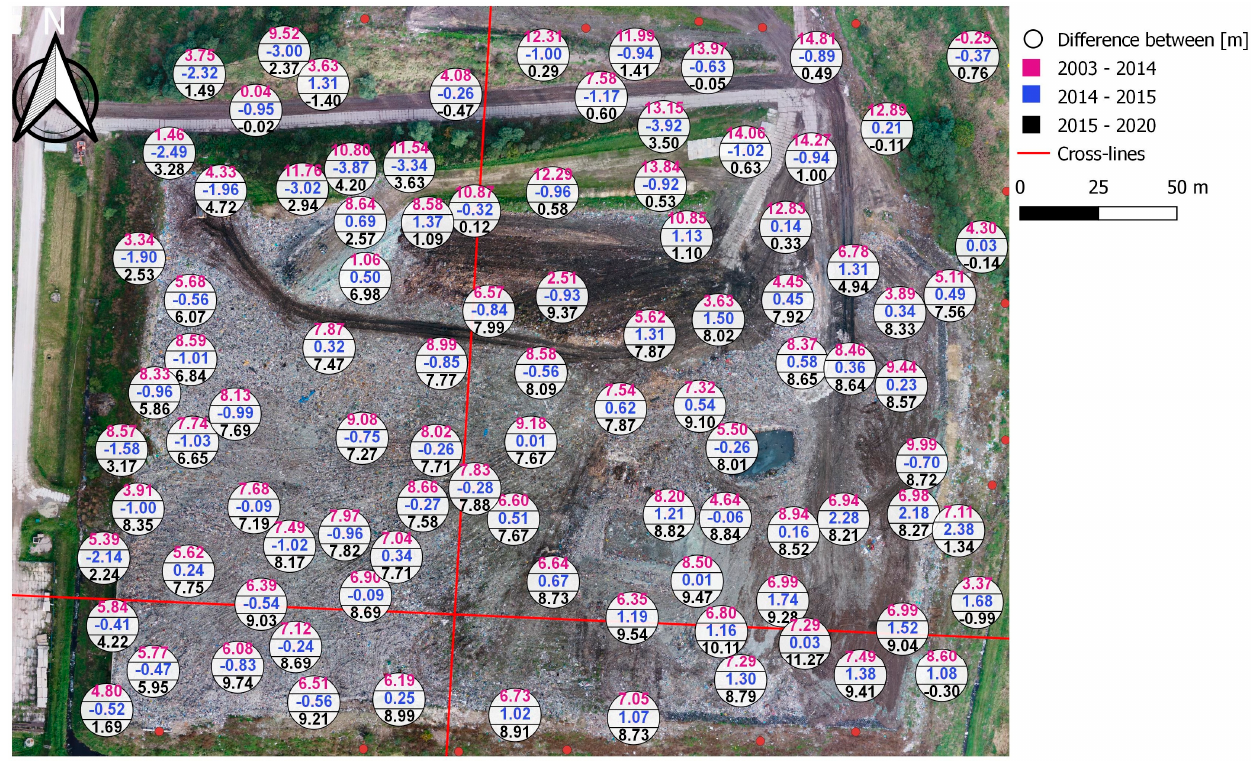
Figure 5. Southern active quarter of the landfill with thickness differences in probe points.